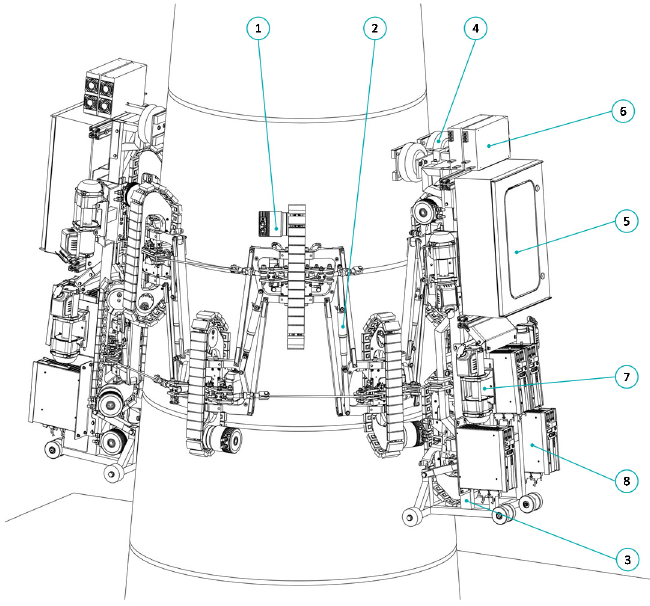
Figure 5. Climbing ring robot (scaled 1:3).